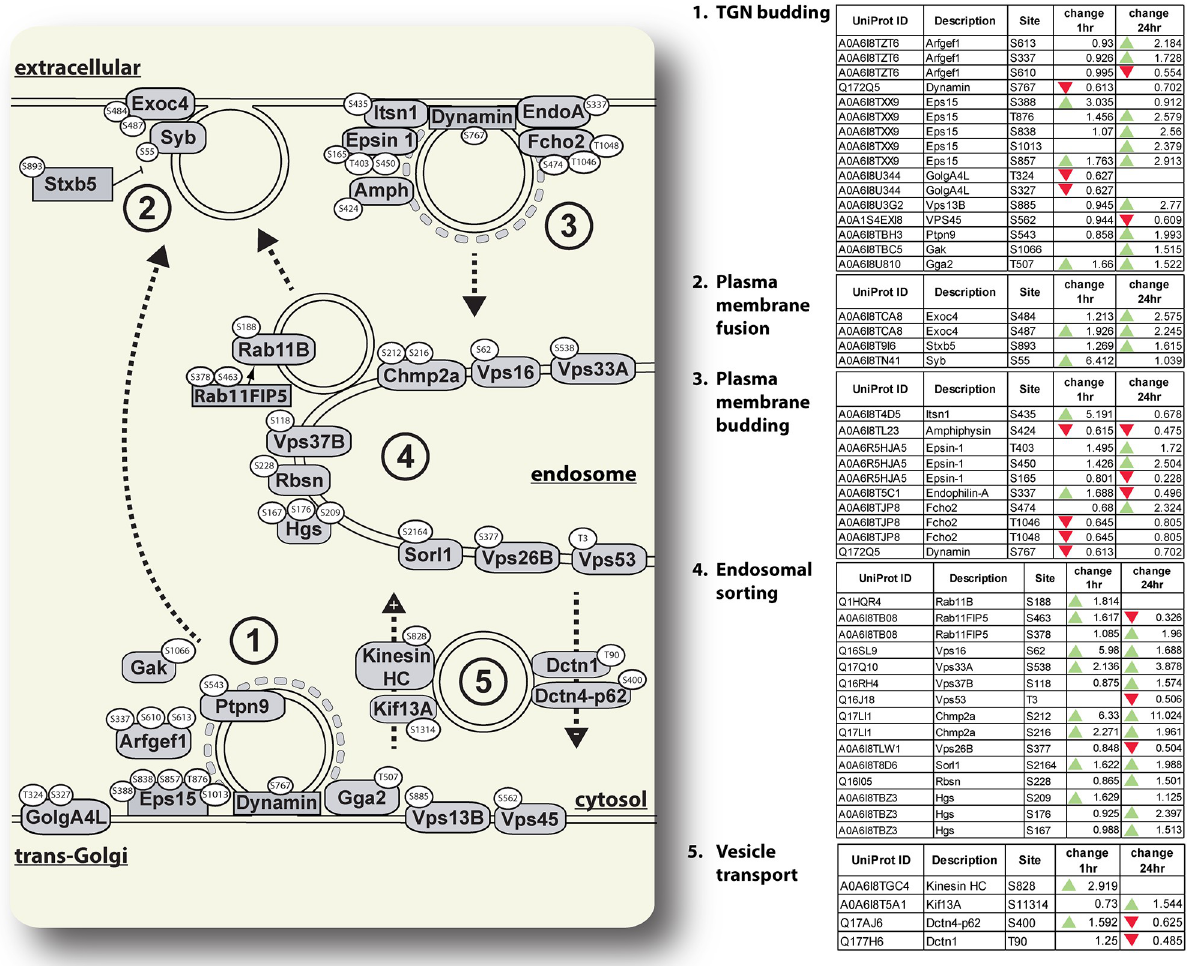
Fig 4. Changes in phosphorylation of proteins associated with post-Golgi vesicle traffic. Ae . aegypti proteins associated with traffic between the trans-Golgi, cell membrane, and endosome conserved in other eukaryotic organisms are illustrated. Specific amino acid residues on proteins with phosphorylation changes of at least 1.5-fold between unfed and blood-fed mosquitoes are shown in white ovals. The numbers in the figure correspond to tables where proteins with related functions are grouped. Tables contain the Uniprot IDs for each protein as well as the fold-change in phosphorylation of each residue between unfed and either 1hr PBM or 24hr PBM mosquitoes. Green arrows represent an increase of at least 1.5-fold in phosphorylation at the specified residue between unfed and PBM mosquitoes, and red arrows represent a decrease of at least 1.5-fold in phosphorylation at the specified residue between unfed and PBM